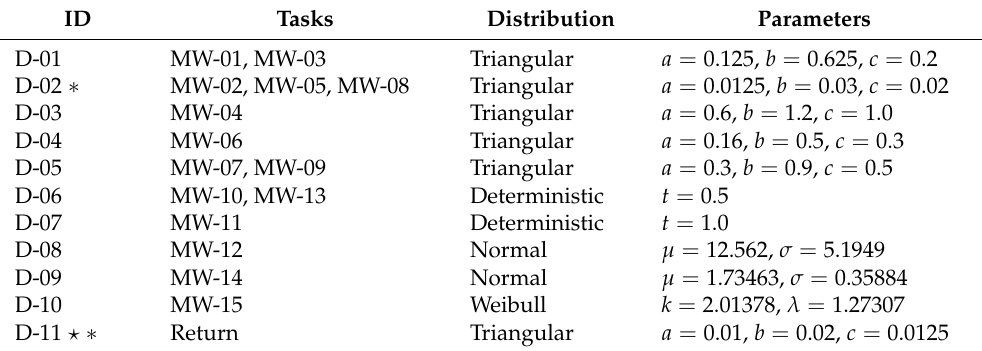
Table 4. Duration in minutes of masonry wall with concrete block tasks.